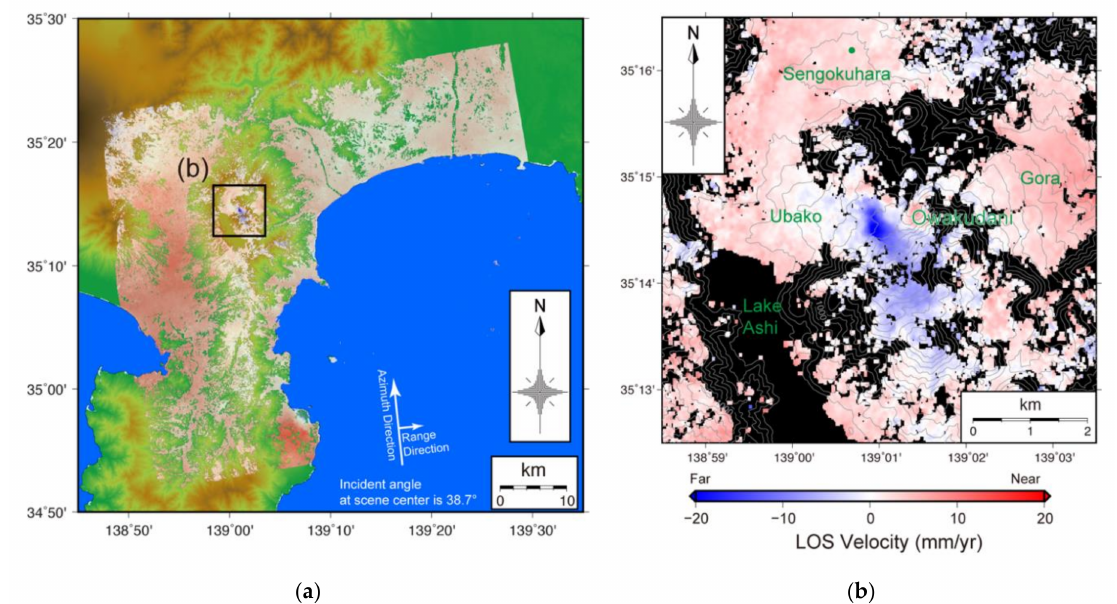
Figure 5. Distribution of line-of-sight (LOS) velocity in the ascending orbit for the ( a ) entire region; ( b ) area of interest shown in the black rectangle (inset) in ( a ). The base map of ( a ) is a topographical map based on 10 m mesh height data released by the GSI, and its color scale is the same as Figure 1. Intervals of contour lines in ( b ) are 50 m in